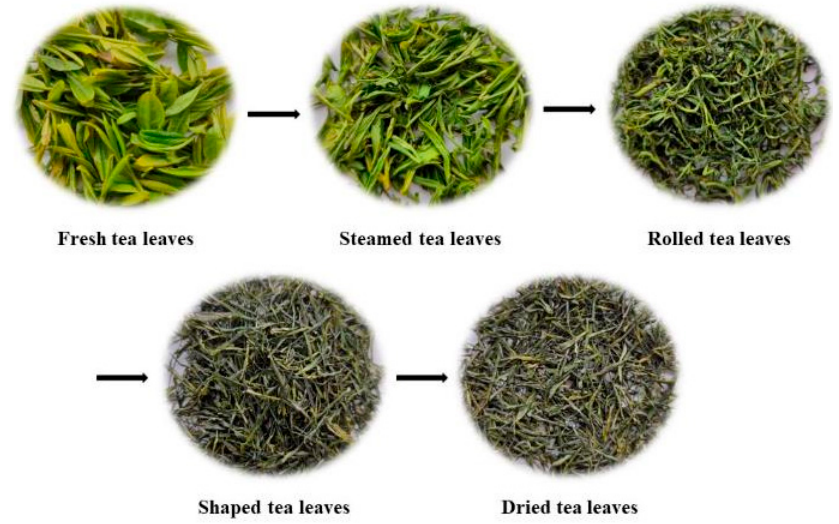
Figure 1. The appearance of tea leaves after the various manufacturing processes.